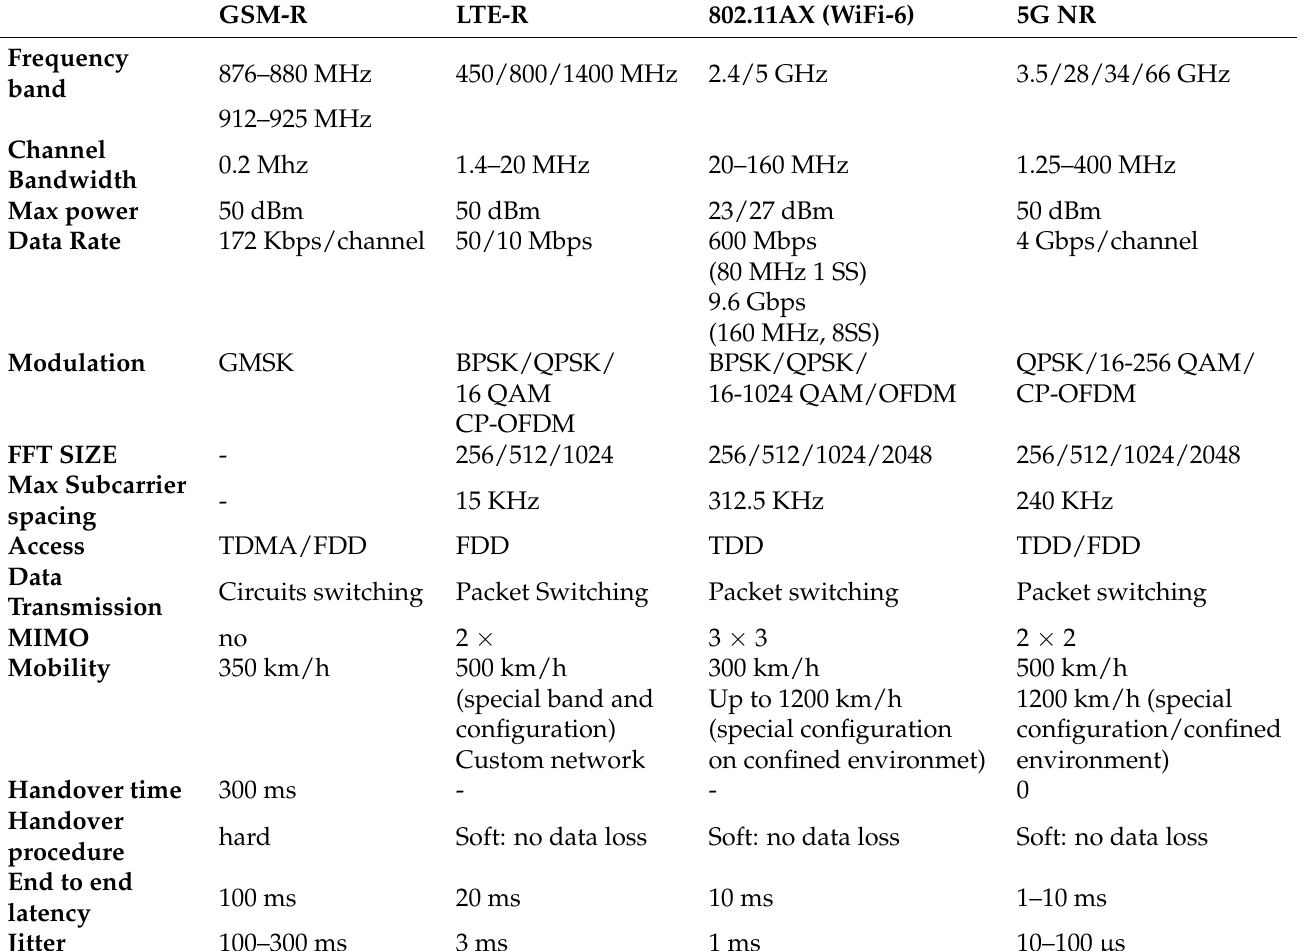
Table 3. Radio standards used for HST critical, performance, and business